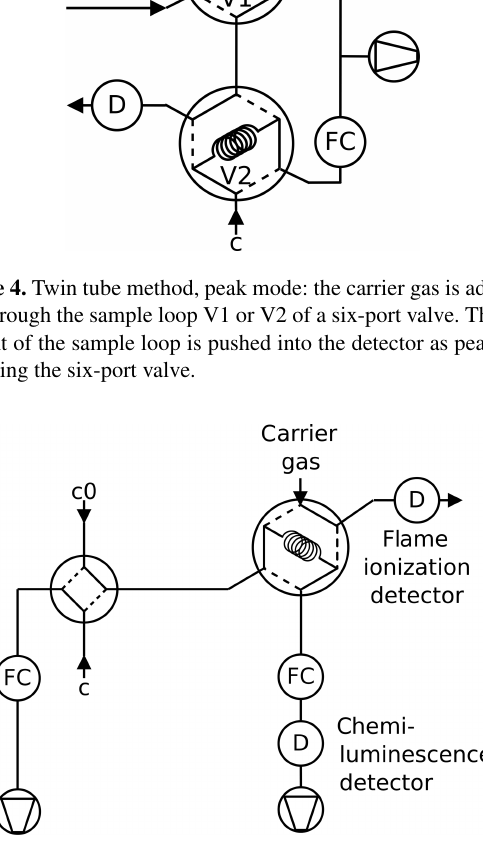
Figure 5. Twin tube method with internal standard as used for NO 2 in N 2 : the species under investigation is monitored in continuous mode, and the internal standard is sampled by a six-port valve and detected by a flame ionization